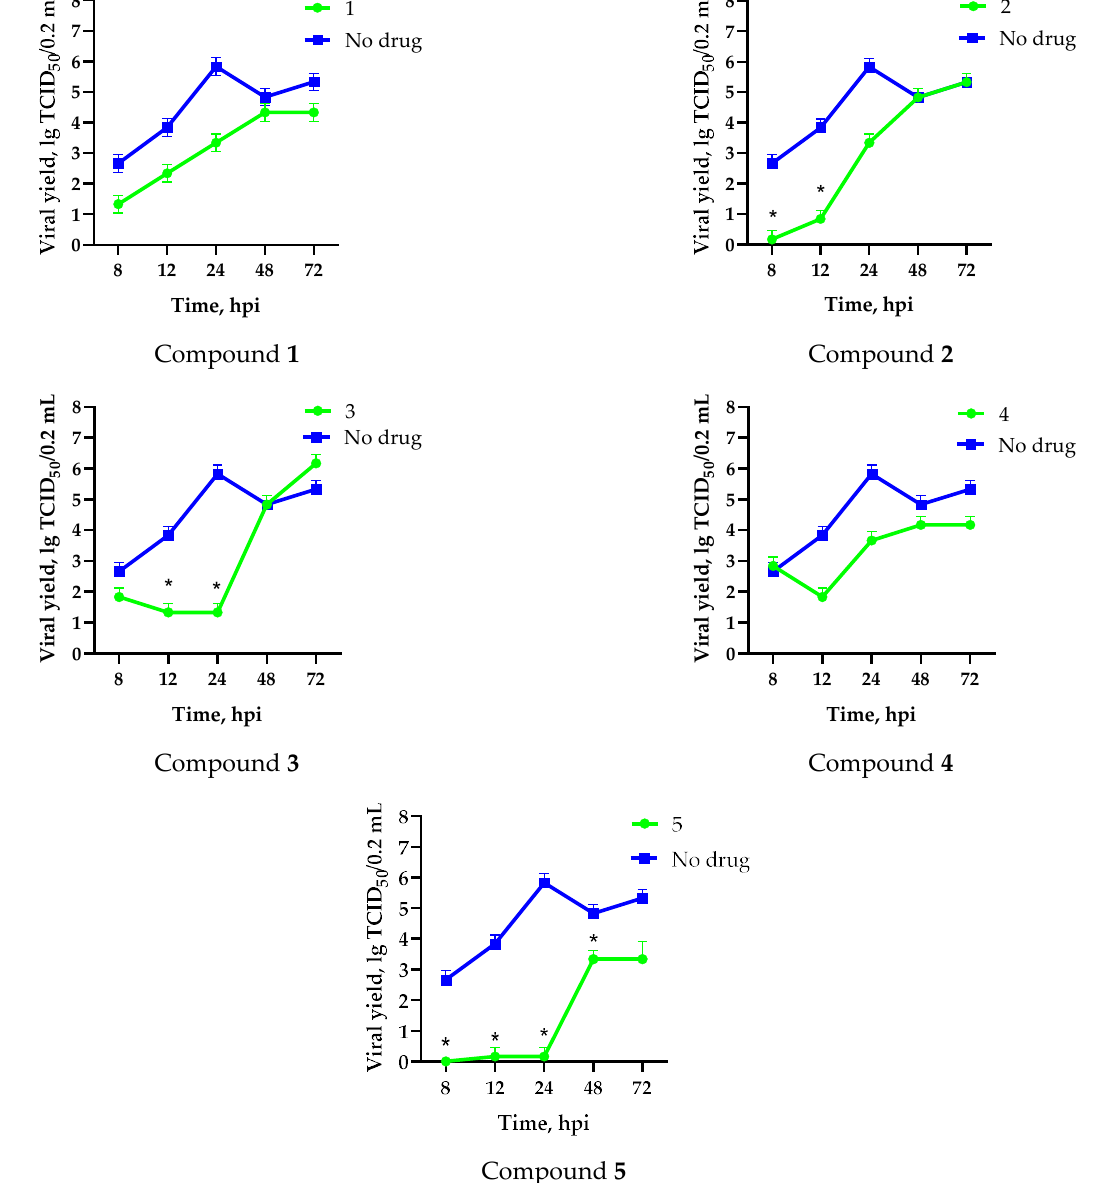
Figure 4. Effect of compounds 1 – 5 on influenza A/Puerto Rico/8/34 (H1N1) viral growth in MDCK cells. Cells were infected with virus (MOI 0.1) in the presence of compounds. Aliquots of culture medium were taken at 8, 12, 24, and 48 hpi. Titration of viral progeny by end-point dilution in MDCK cells with virus detection by hemagglutination assay was then performed. Data are presented as the mean ± SD of three independent experiments. *–differences are significant relative to “no drug” (Kruskal–Wallis test, p < 0.05).